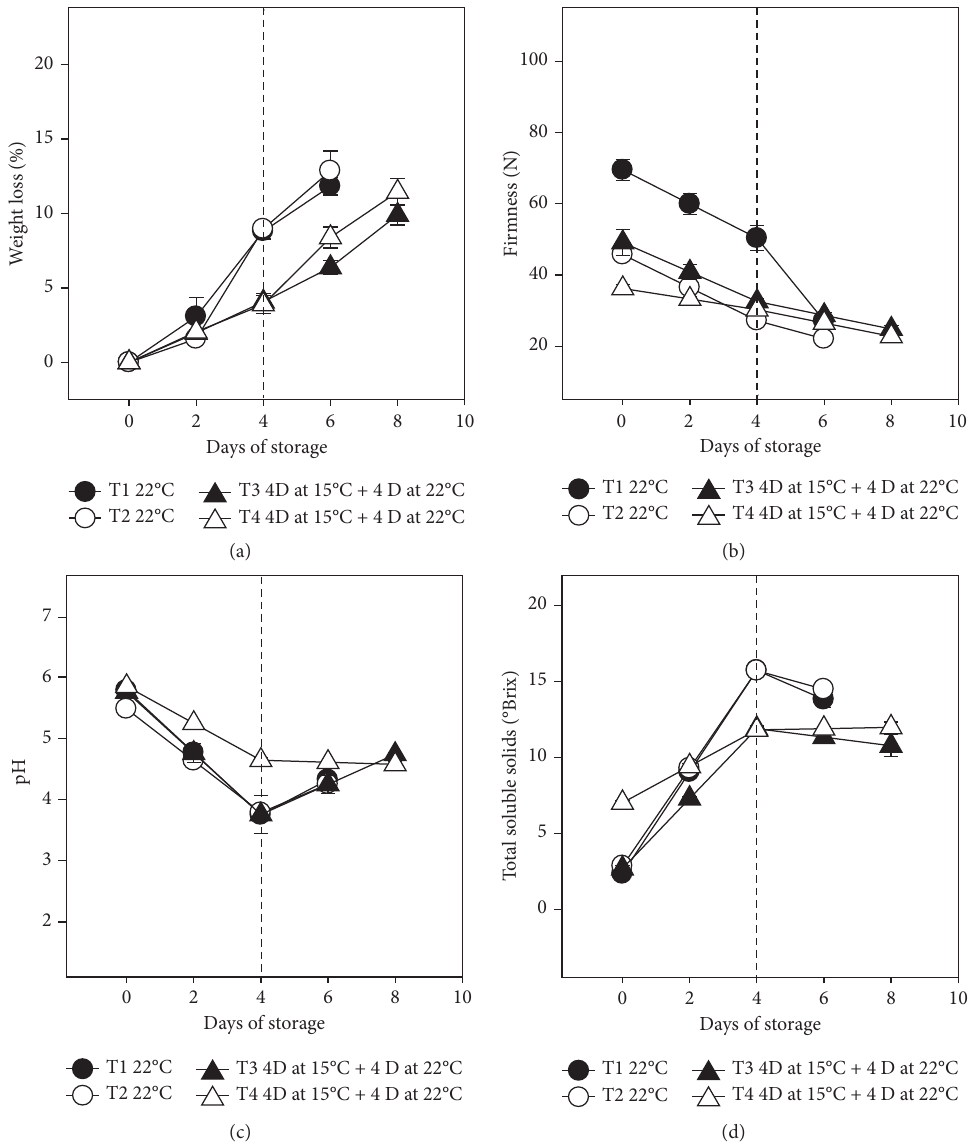
Figure 1: Weight loss (a), firmness (b), pH (c), and total soluble solids (d) in soursop fruits stored at 22 ° C and 15 ° C. Each point represents the average of six observations and its standard error. The dotted line indicates the end of refrigeration